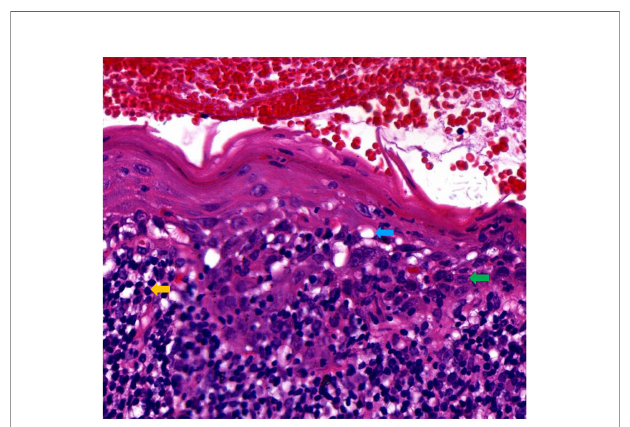
FIGURE 2 | Histopathological features of this patient. Histopathological features for the biopsy taken from the lesions on the left buccal mucosa (H&E staining, original magni fi cation, x200). Blue, green and yellow arrows indicated the vacuolar degeneration, plasma cell and lymphocyte, respectively.